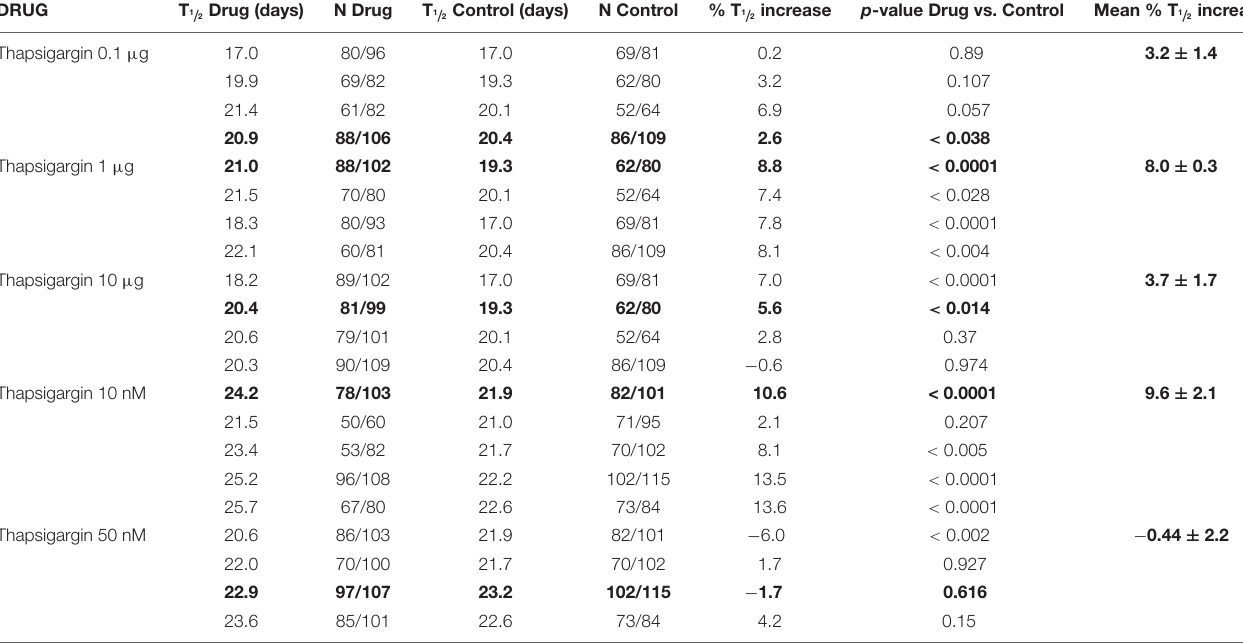
Drug (days) N Drug T 1 / 2